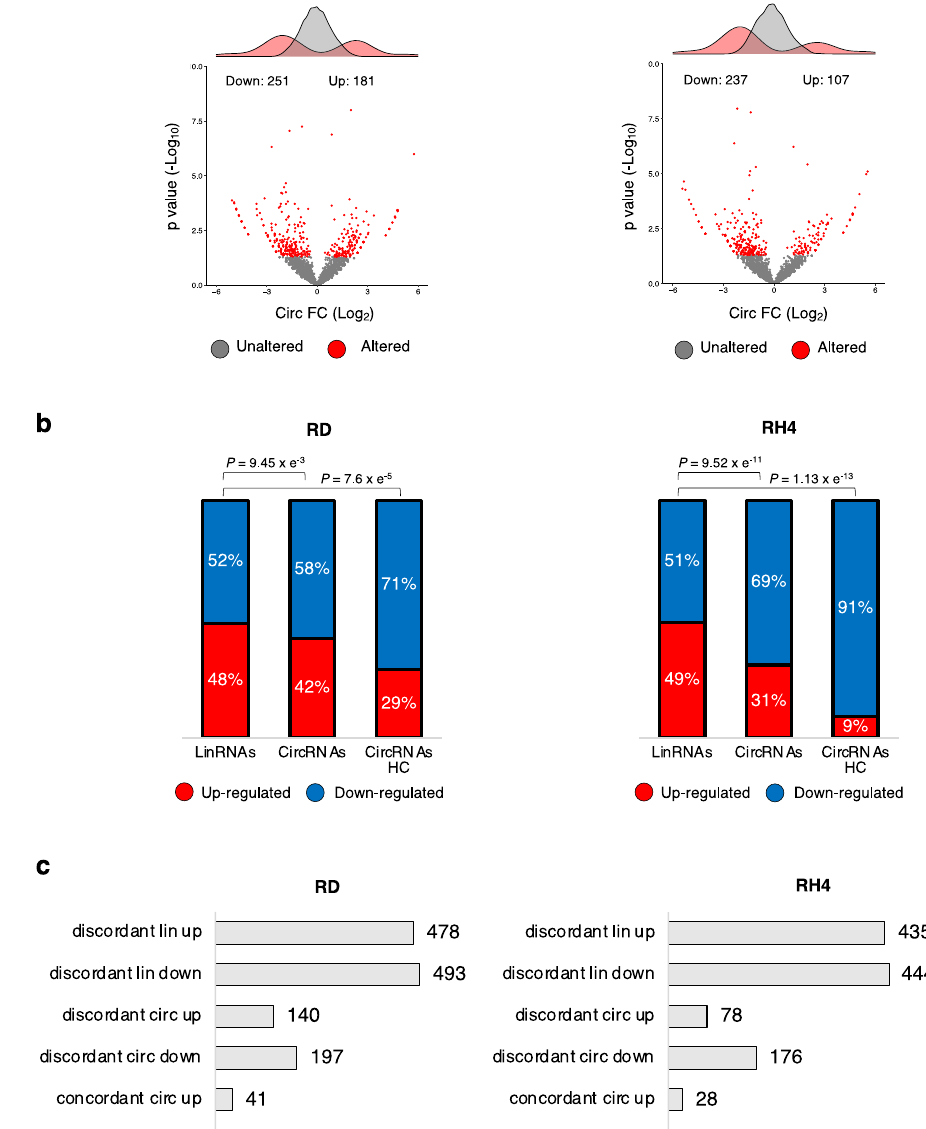
Fig. 3 | YTHDC1 depletion downregulates circRNAs in RMS. a Volcano plots showing for each circRNA identi fi ed in the RNA-seq experiment the log 2 fold change and the − log 10 p value upon YTHDC1 knock-down in RD (left panel) or in RH4(rightpanel)cells.Thedistributionsofthefoldchangevaluesareshownabove the volcano plots. Signi fi cantly altered circRNAs ( p value <0.05) or unaltered cir- cRNAs are indicated by red or gray dots, respectively. See the methods section for statistical analyses details. b Stacked bar charts with percentage of down- and